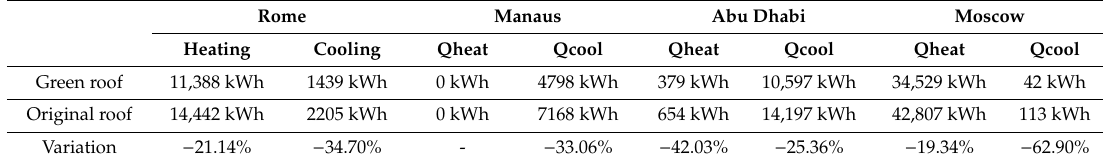
Table 2. Comparison among heating and cooling energy needs in di ff erent climatic